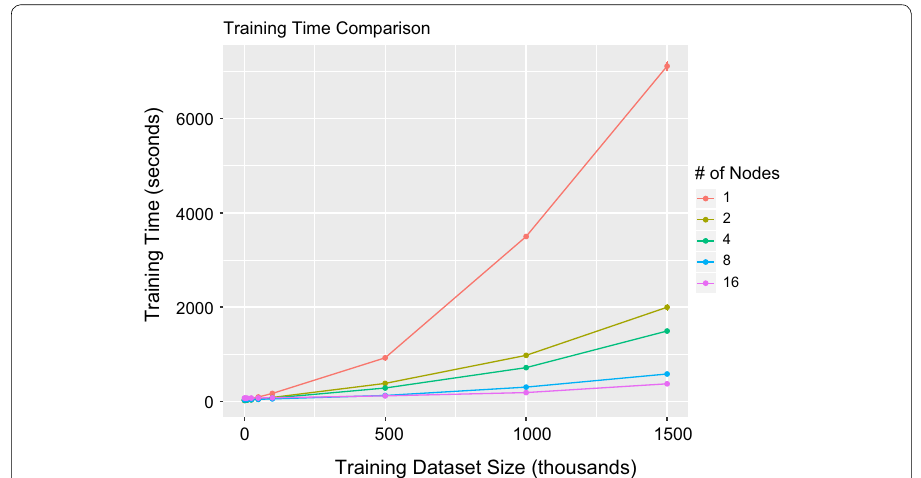
Fig. 2 Visualization of training time with respect to training data size in thousands. Each line represents results from a cluster with N number of nodes. Note that the X and Y scale are linear